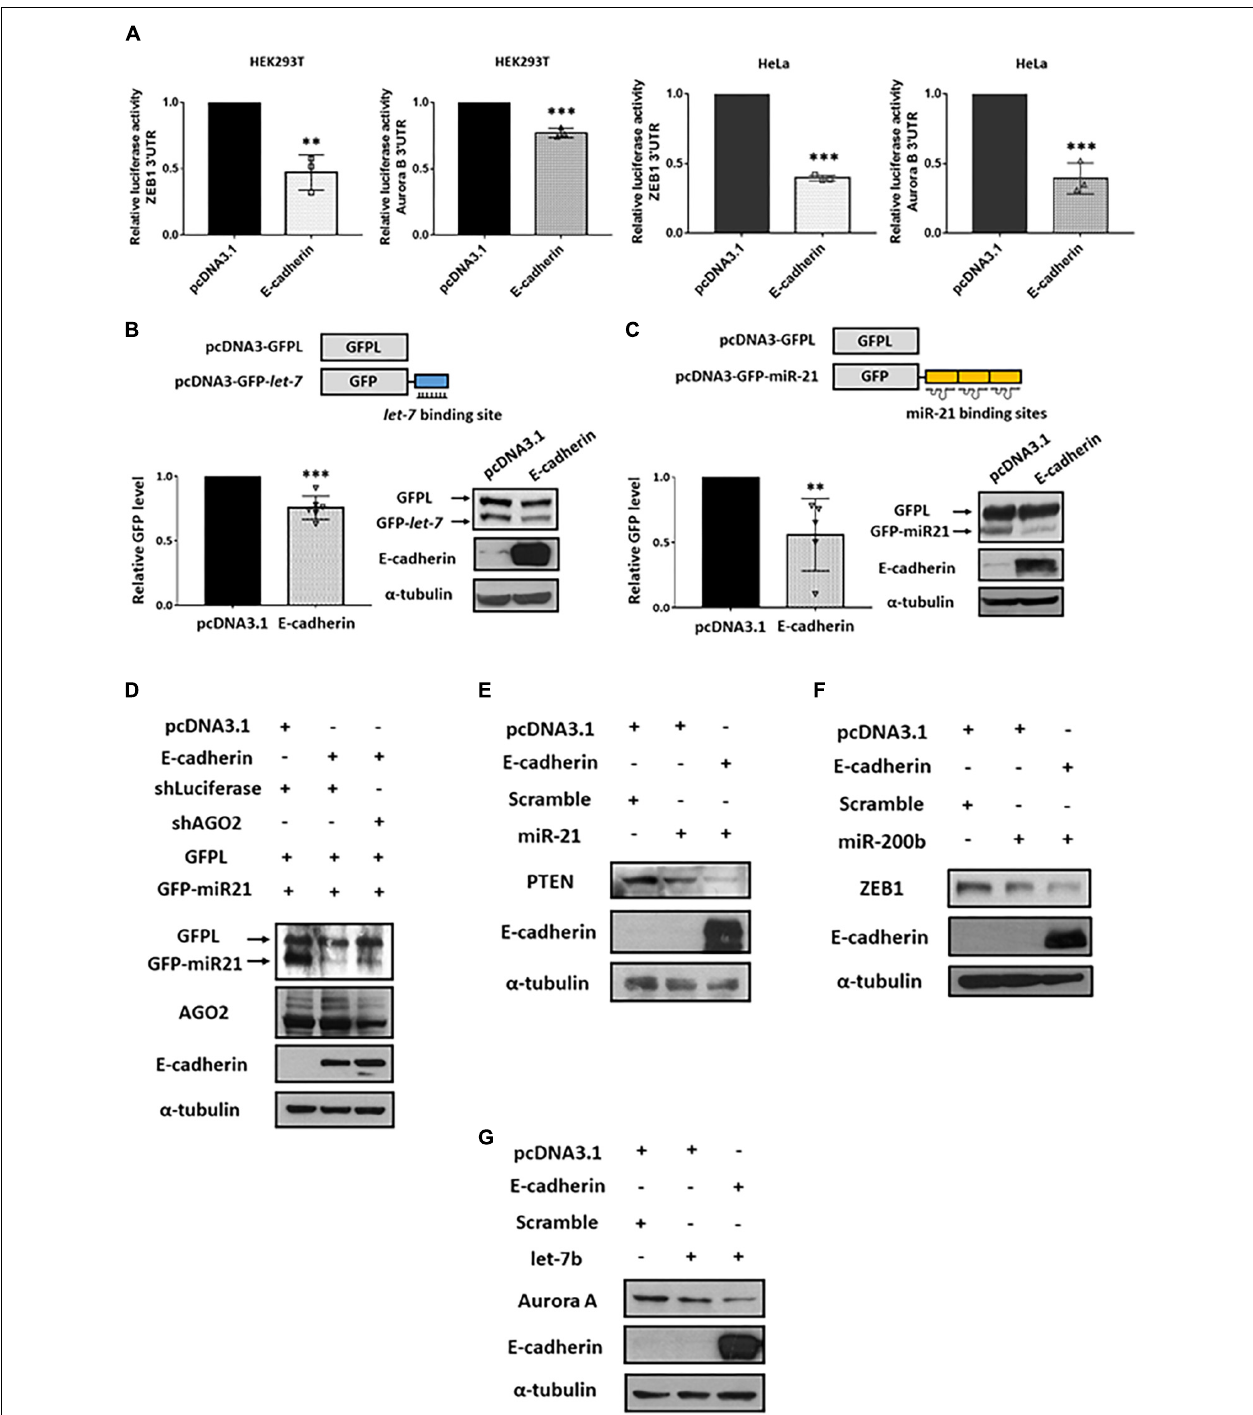
FIGURE 4 | E-cadherin enhances miRISC-mediated gene silencing. Effect of E-cadherin on miRISC activity. (A) HEK293T or HeLa cells were transfected with ZEB1 or Aurora B 3 (cid:48) UTR reporter plasmids for 24 h. The luciferase activities were determined in E-cadherin-overexpressing HEK293T (purple) or HeLa (green) cells. E-cadherin-overexpressing HeLa cells were transfected with GFP-let-7 (B) or GFP-miR-21 (C) for 24 h to determine miRISC activity. (D) AGO2 was knocked down in E-cadherin-overexpressing HeLa cells. The cells were then transfected with GFP-miR-21 for determining miRISC activity. Cells were transfected with GFPL for transfection control. GFP and GFPL expression were determined by western blot using anti-GFP antibody. E-cadherin-overexpressing HEK293T or HeLa cells were transfected with miR-21 (E) , miR-200b (F) , or let-7b (G) for 24 h for analysis the expression of their target genes including PTEN, ZEB1, and Aurora A by western blot. Data are presented as mean ± SEM of at least three independent experiments and analyzed by two-tailed Student’s t -test. ∗∗ p ≤ 0.01 and ∗∗∗ p ≤ 0.001.